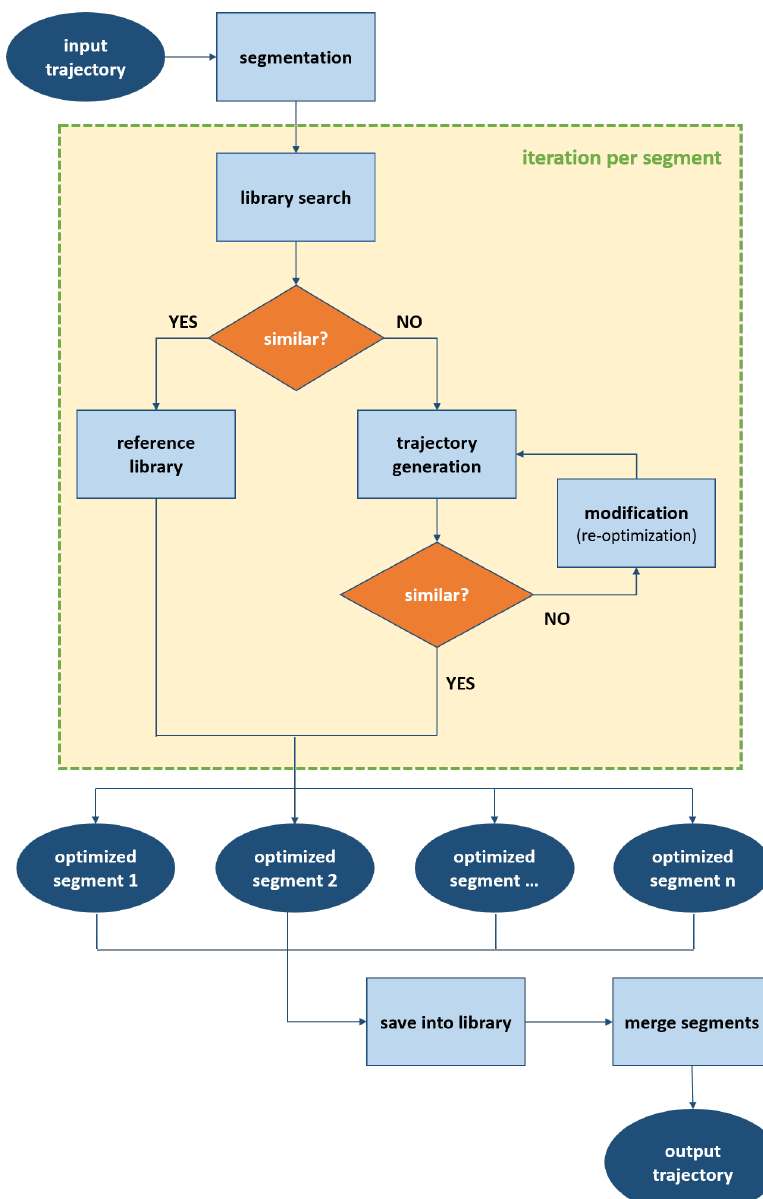
Figure 5. Overview of generation of optimized trajectory using an iterative search method.